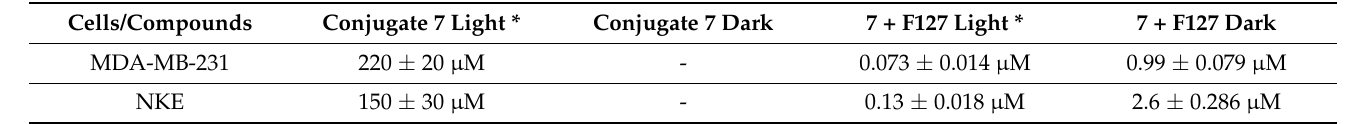
Table 1. IC 50 of compound 7 in the MDA-MB-231 and NKE cell lines.